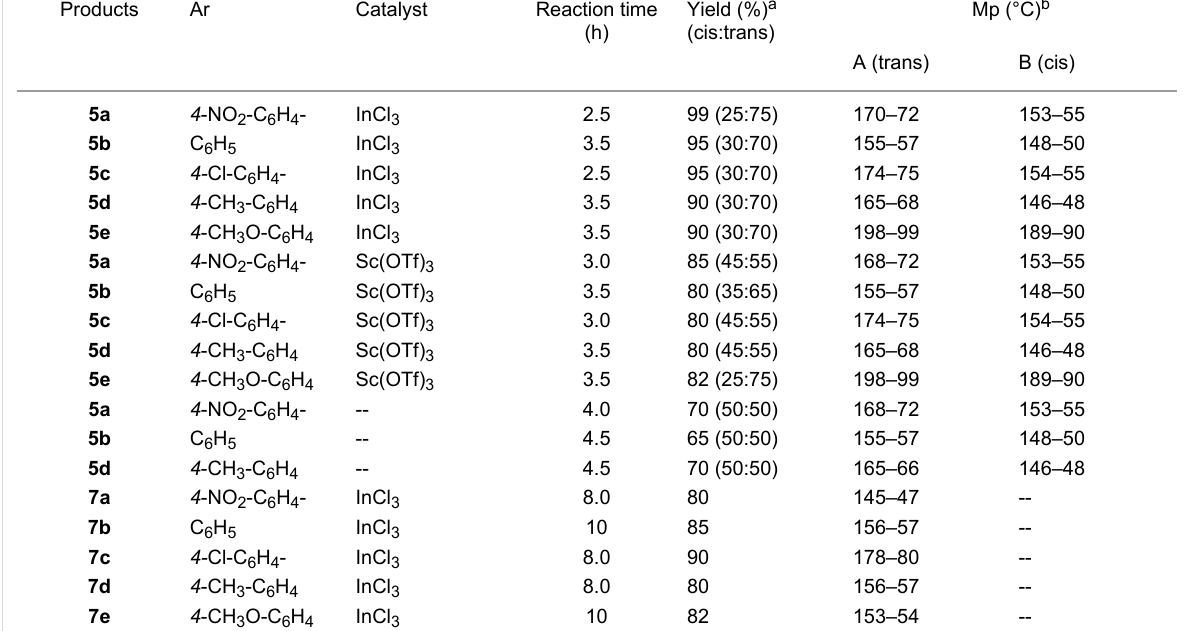
Table 1: Inverse electron-demand hetero-Diels-Alder reaction for the synthesis of pyrano [2,3- d ]pyrimidines 5 and furopyrano [2,3- d ]pyrimidines 7 .